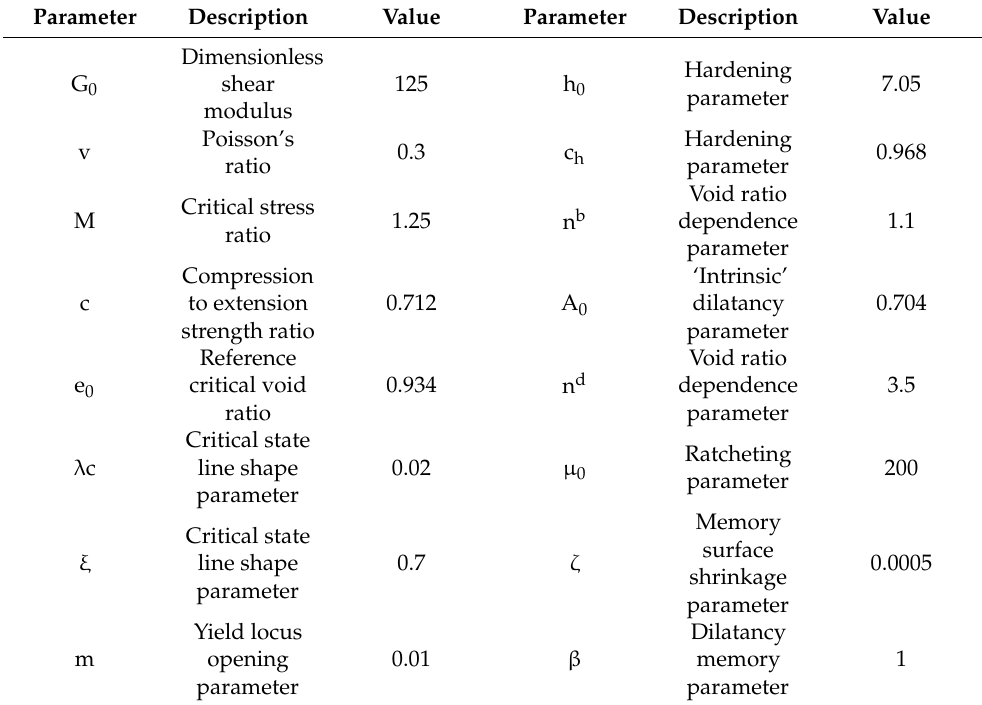
Table 1. Values of parameters used in the memory surface constitutive model [ Error! Reference source not found. , Error! Reference source not found. ].